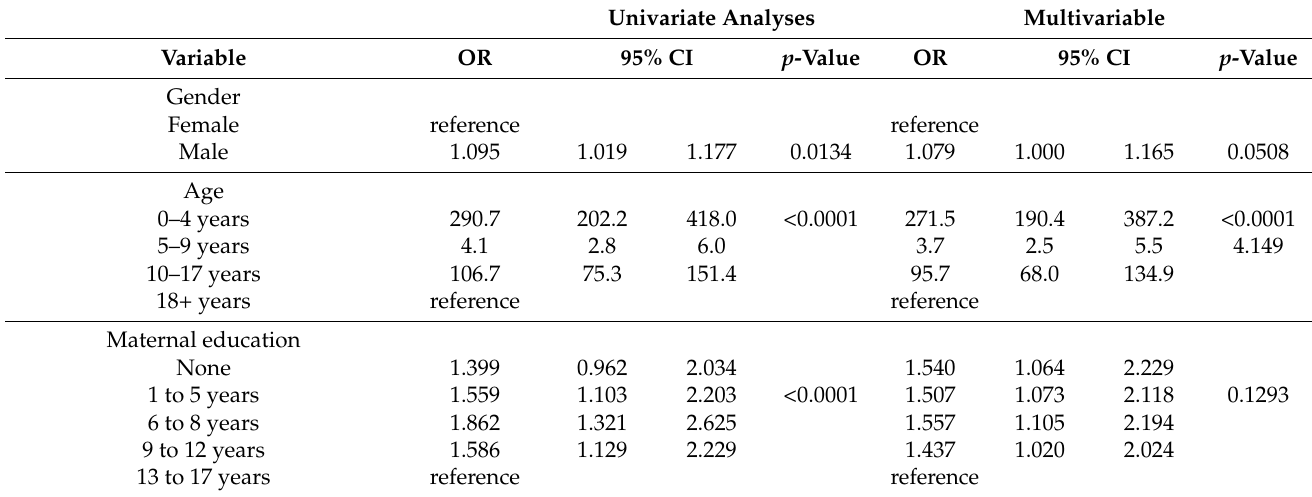
Table 5. Factors associated with non-fatal drowning among samples from Barishal Division, Bangladesh. Univariate Analyses